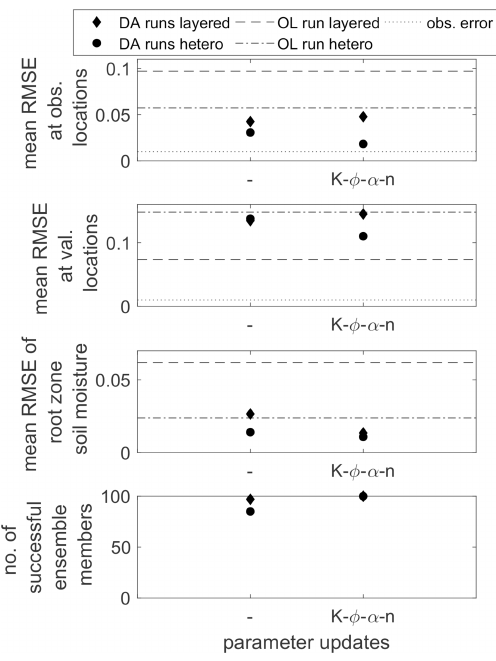
Figure 19. Spatially and temporally averaged RMSE values at the observation and validation locations and for the averaged root zone soil moisture for the heterogeneous scenario using a heterogeneous and a simplified layered structure in the ensemble. The first en- try (–) denotes the data assimilation run where only soil moisture is updated. The lower plot gives the number of converging ensem- ble